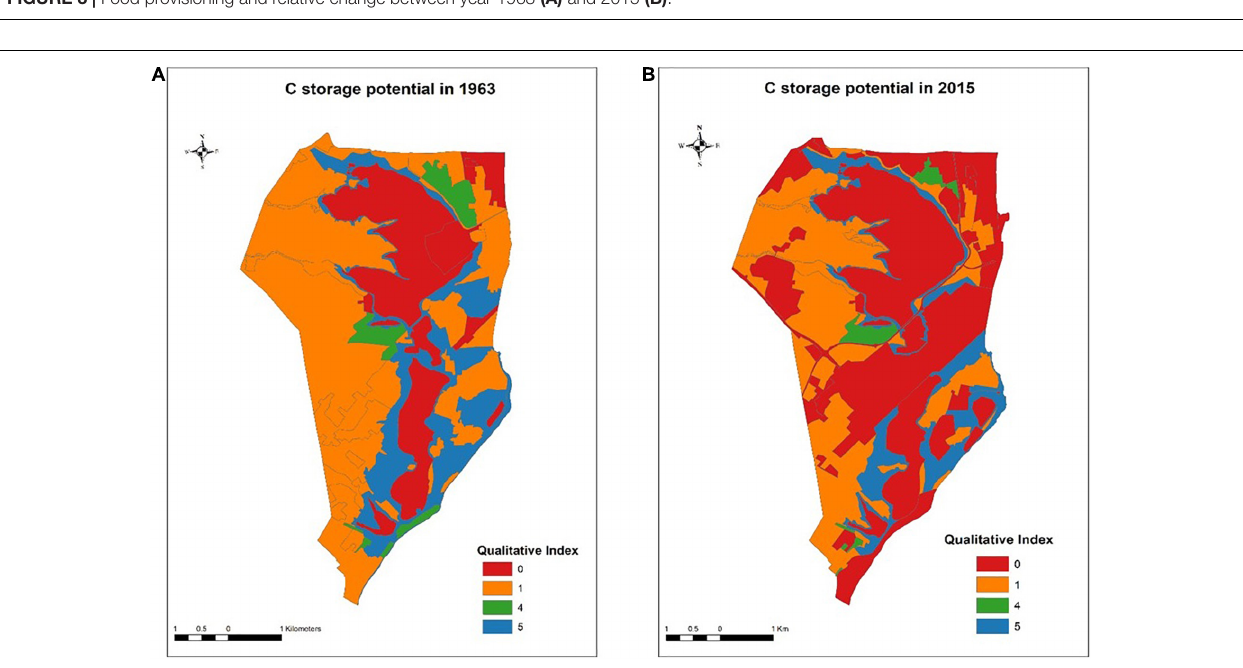
FIGURE 3 | Food provisioning and relative change between year 1963 (A) and 2015 (B) .